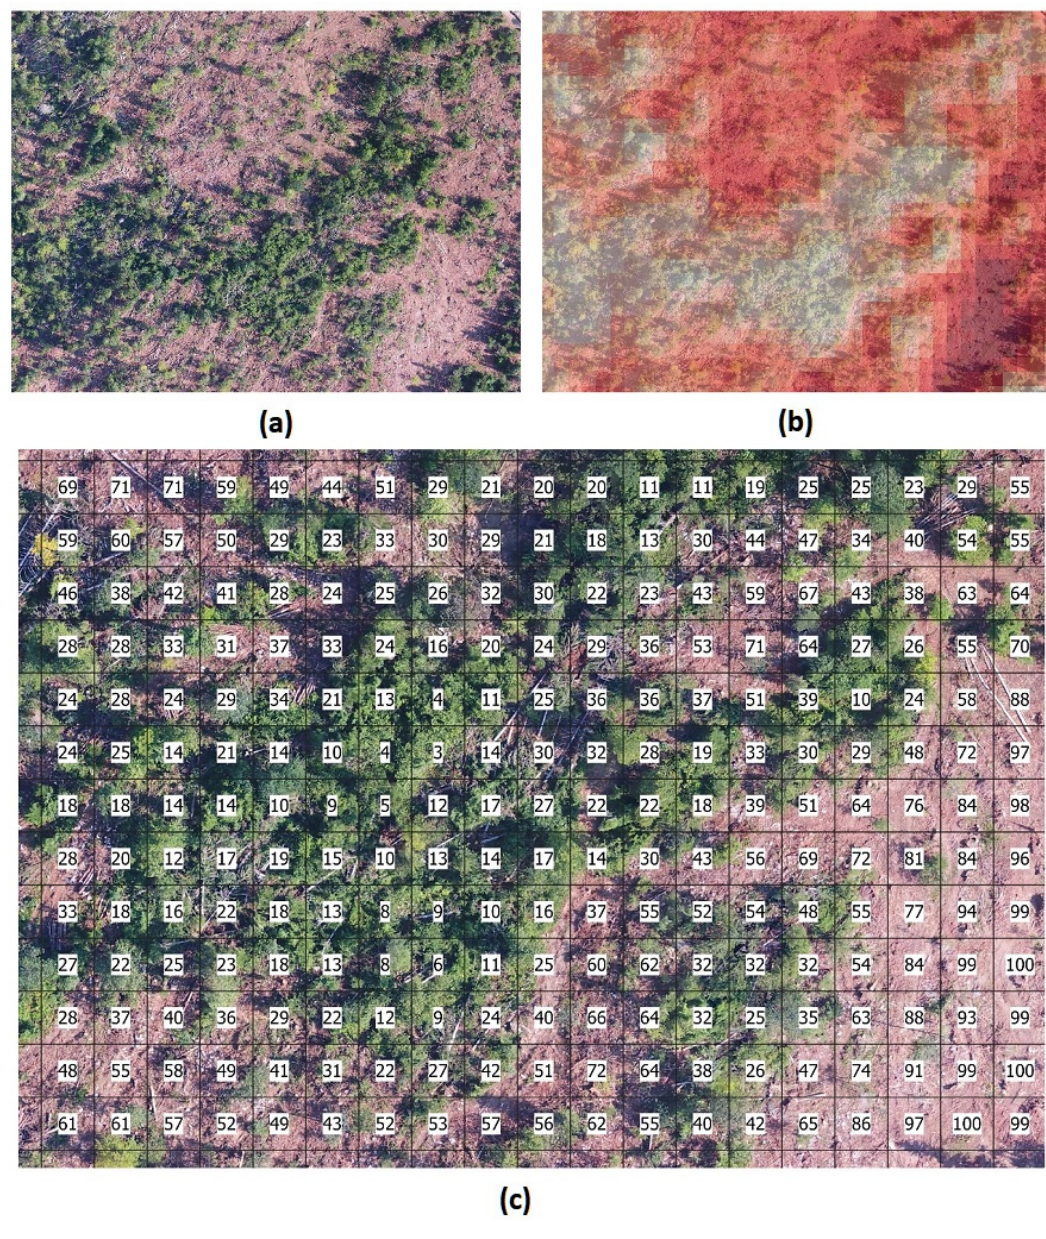
Figure 6. Representation of map precision. ( a ) Detail of the area obtained using UAV image; ( b ) the same detail with overlaid COP map including marked areas in red that indicate disturbances in the canopy; ( c ) precision of the map can be also perceived from the labels that display COP values in percentages across the S-2 polygon grid .